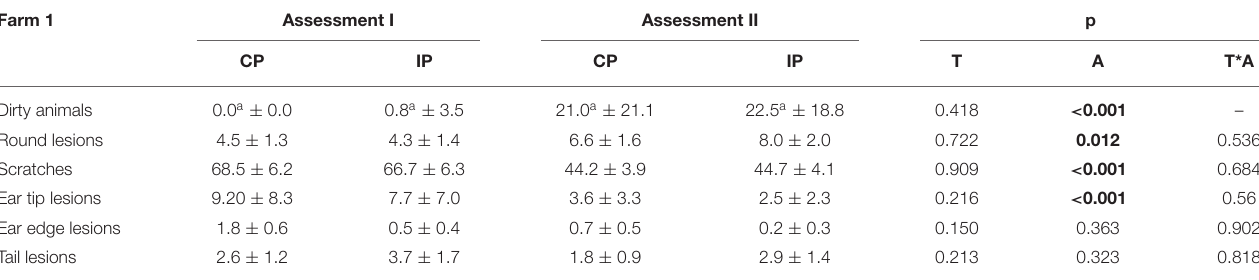
TABLE 7 | Prevalence of lesions and soiled pigs (mean percentage of animals per pen; LS-means ± standard error of means) for pigs in IP (improved pens) and CP (control pens) during assessments I (baseline) and II (middle of the fattening period) on Farm 1. Farm 1